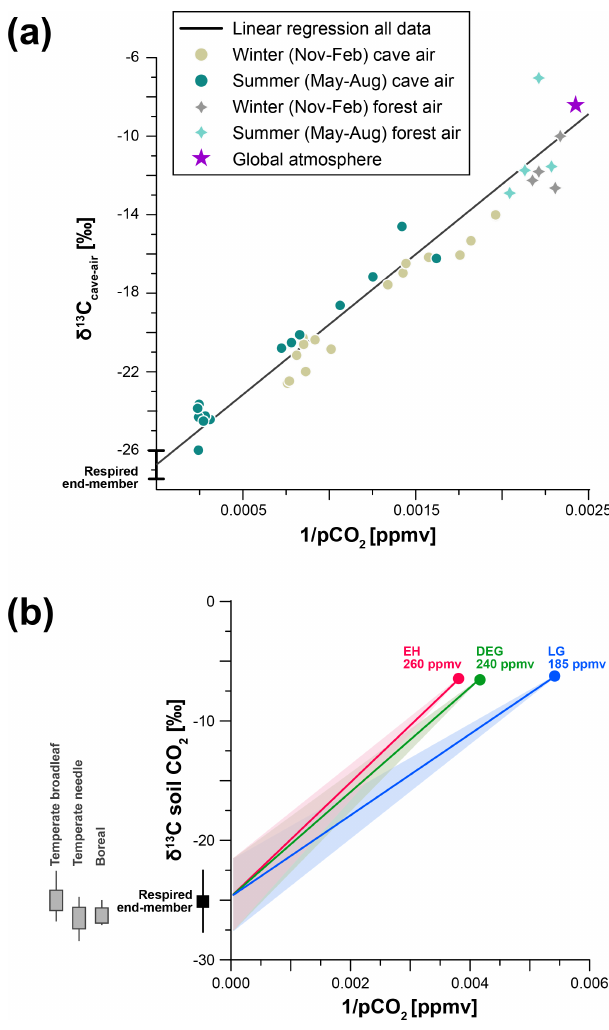
Figure 3. (a) Keeling plot of cave and local atmospheric CO 2 used to define the respired end-member of soil gas. The respired end- member is defined through linear regression of the entire dataset. (b) Mixing lines defined for the model simulations of past soil gas p CO 2 and δ 13 C. We define three mixing lines based on the changes in the atmospheric composition (EH, DEG, LG). All three mixing lines use the same respired end-member, with a variability of ± 3‰ to account for changes in respired substrate. Mean respired δ 13 C of soil CO 2 across relevant biomes, adapted from Pataki et al. (2003), is shown on the